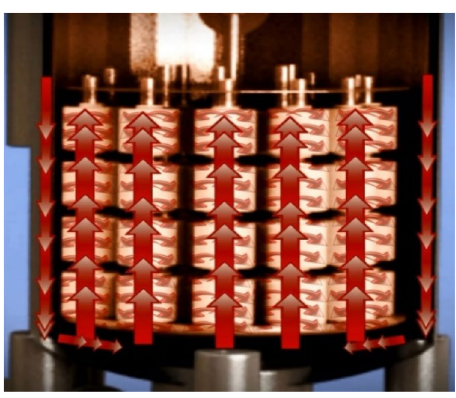
Figure 2. Flow of water from inside the cone to outside [Courtesy of EL Sharq El Awsat Co.].